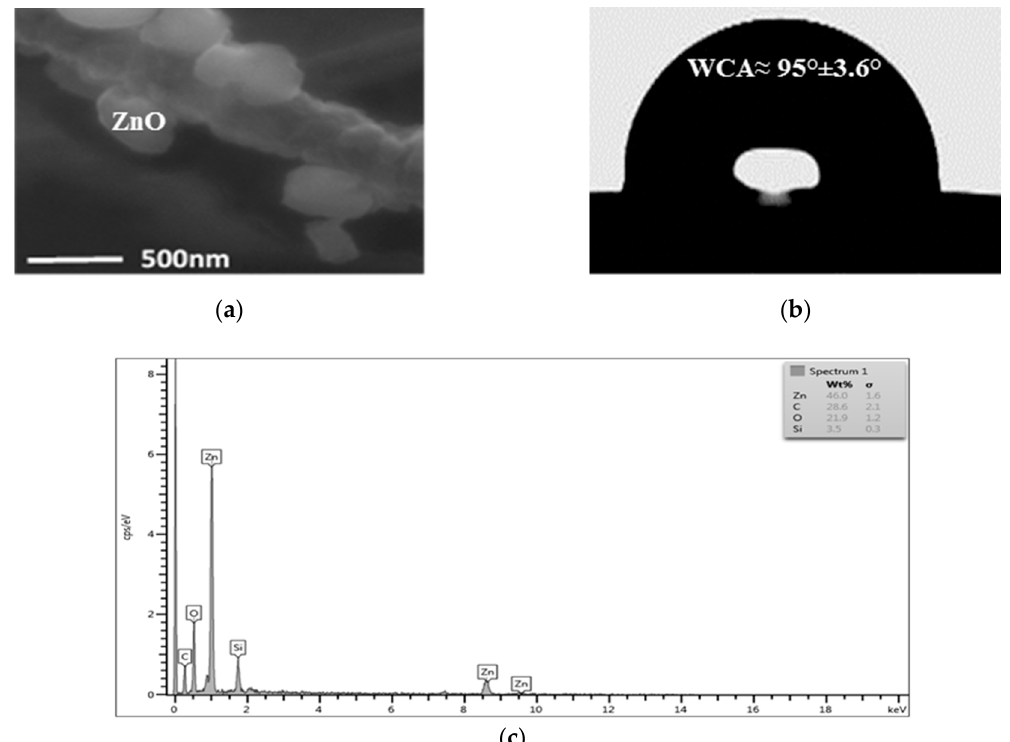
Figure 3. Characterisation of LDPE films coated with chitosan-ZnO nanocomposite. ( a ) SEM image of the coated LDPE (20,000 ×); ( b ) Measurement of static contact angle of a water droplet on coated LDPE, the data are means ± standard deviations of five replicates; ( c ) Energy Dispersive Spectrometry (EDS) spectrum of LDPE surface coated with Chitosan-ZnO nanocomposite. Each peak represents different elements.